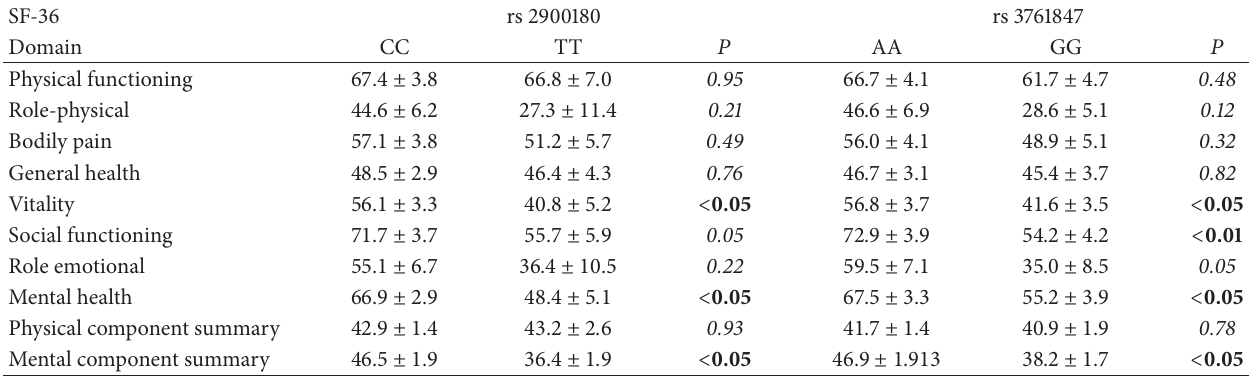
Table 2: Relationship between features of SF-36 and analyzed polymorphisms.